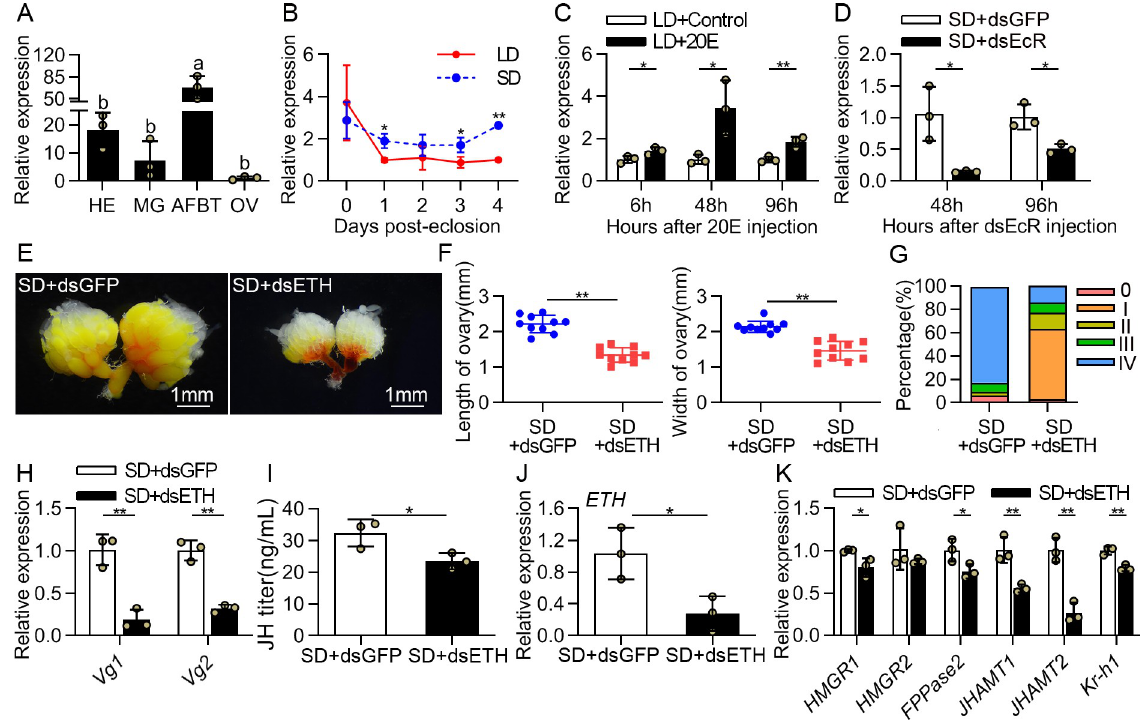
Fig 6. Knocking down ETH arrests ovarian development and decreases JH signaling under SD condition. (A) Tissue distribution of ETH in SD-induced females at 4 days PE. HE, head; MG, midgut; AFBT, abdominal fat bodies attached with trachea; OV, ovary. Relative gene expression values in the tissue samples are presented as fold changes compared to the ovary samples. (B) Patterns of ETH expression detected by qRT-PCR in the in the AFBT tissues on 0–4 days after eclosion. Relative expression levels of genes at different time points are presented as fold changes compared to the LD females at 4 days PE. (C) The transcriptional expression of ETH was analyzed after 20E injection for 6, 48 and 96 h in the AFBT tissues of the LD-induced females. (D) qRT-PCR of ETH in the AFBT tissues of SD-females injected with dsEcR, analyzed at 48 and 96 h. (E-G) Effect of knockdown of ETH in female on ovarian development and ovary length and width. (H) Relative expression levels of Vg1 and Vg2 after dsETH injection measured by qRT-PCR in the fat bodies. (I) Reduction of JH titer in SD-females following ETH silencing. qRT-PCR measurement of (J) ETH , (K) JH biosynthetic genes and Kr-h1 expression levels were analyzed in the heads after dsETH treatment. The relative gene expression levels in the treatments are presented as fold changes compared to the control groups. Different letters above bars indicate significant between-group differences determined by one-way ANOVA followed by Tukey’s LSD test ( α = 0.05). Error bars represent the sd. � P < 0.05, �� P <